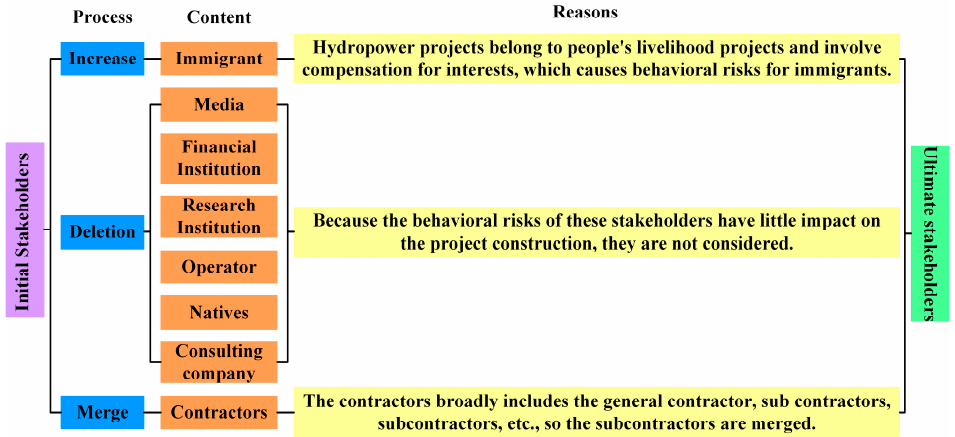
Figure 2. Stakeholder Identification Process.